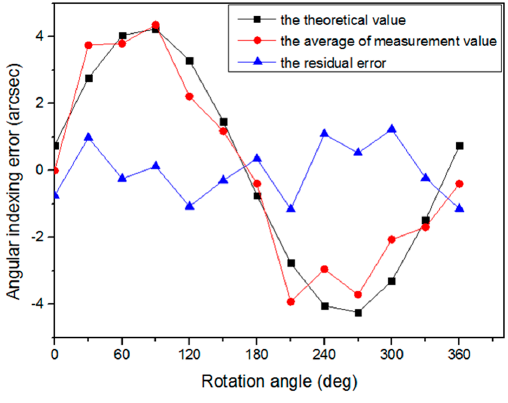
Figure 14. The measured and theoretical values of the angular indexing errors of the mandrel.